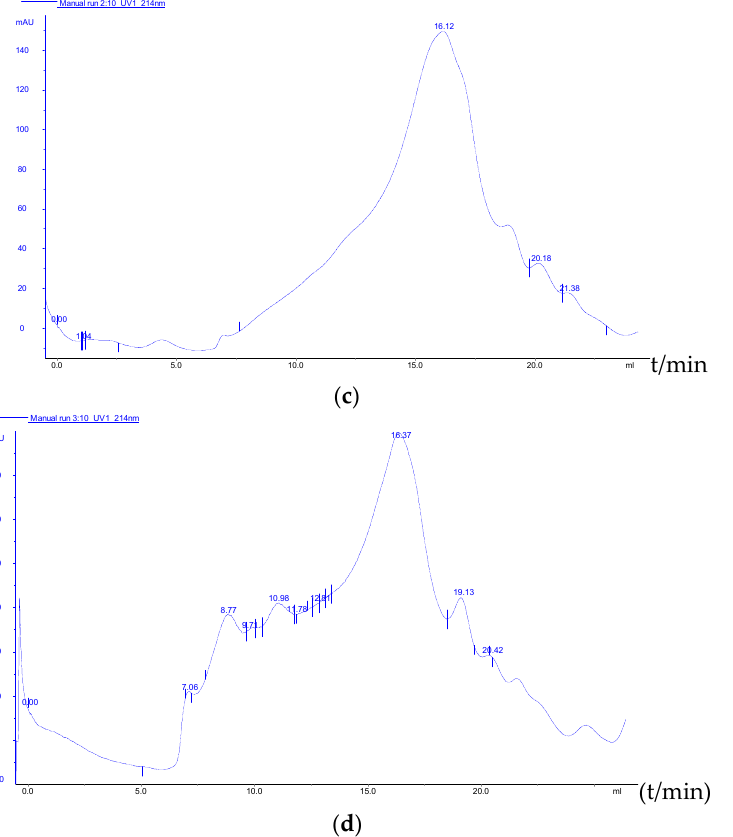
Figure 6. Weight distribution of rapeseed meal (RSM) and fermented rapeseed meal with acid protease (FRSMP): ( a ) SDS-PAGE pattern of the RSM and FRSMP (1, RSM; 2, FRSMP); ( b ) standard curve, the ordinate is Height (mAu); ( c ) weight distribution of RSM, the ordinate is Height (mAu); ( d ) weight distribution of FRSMP, the ordinate is Height (mAu).